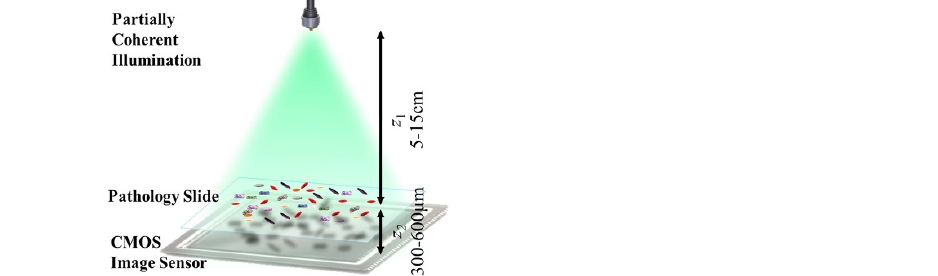
Figure 1. Typical schematic of lens-less diffraction microscopy setups based on a single frame [39].